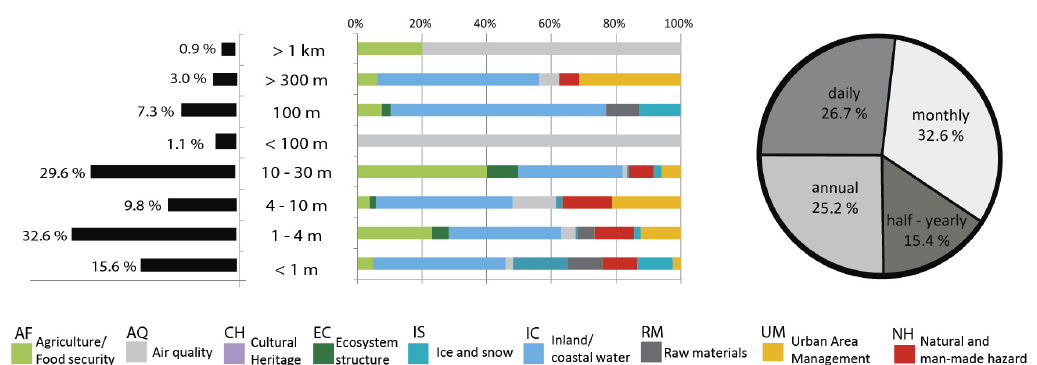
Figure 11. Frequency distribution of spatial and temporal resolutions. From left to right: frequency distribution of spatial resolution classes as sum of the preference expressed by all the thematic areas on each class and the frequency of the preferences expressed by each thematic area in each class; the circular graph summarizes the preferences on the temporal resolution.